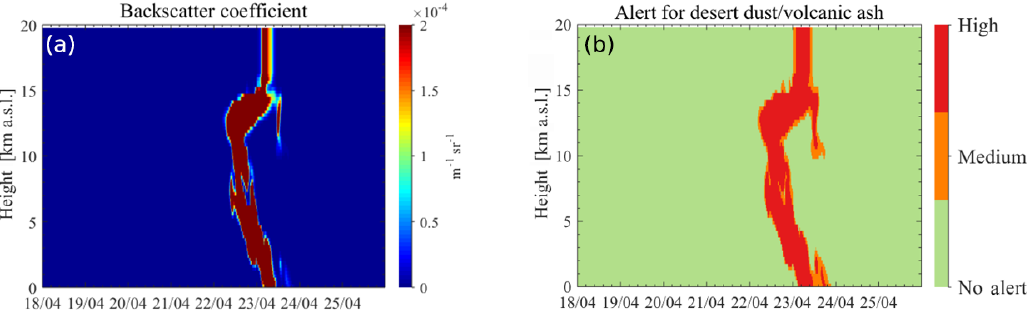
Figure 8. The attenuated backscatter coefficient (a) and the alert for aviation (b) for the Leipzig EARLINET